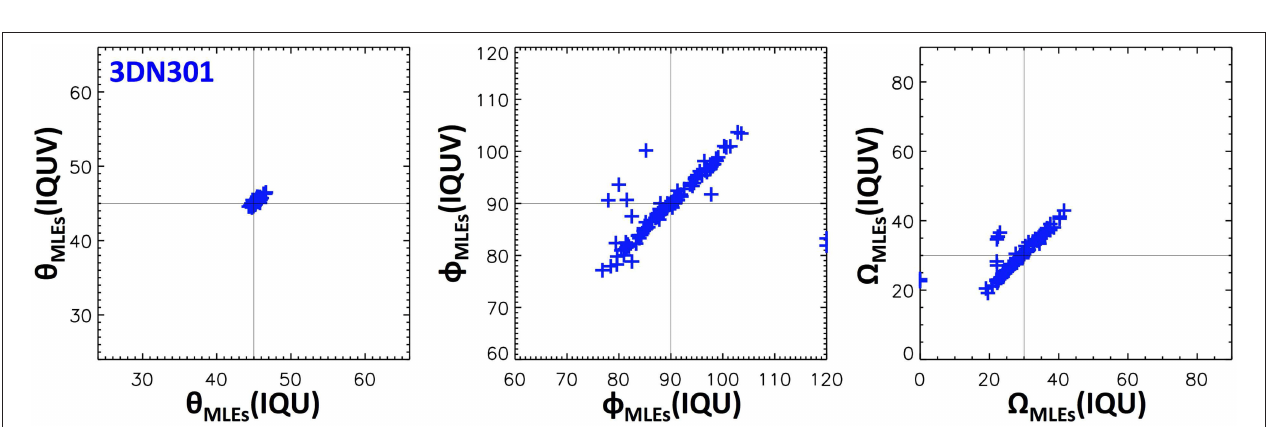
FIGURE 6 | Comparison between polarization signal showing the benefit of steps 4 and 5 of ROAM (see Section 2), for one of the designs of the 3DN301 case. Left column: ground-truth. Middle Column: fully optimized solution (all five steps of the method are applied). Right column: initial guess from the design (i.e., when omitting steps 4 and 5 of ROAM).